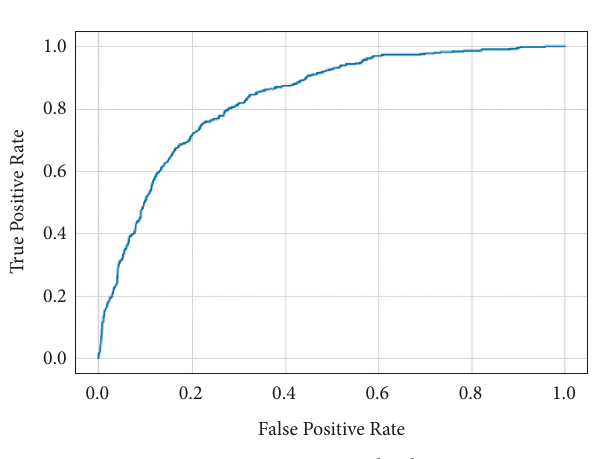
Figure 8: ROC curve bank.